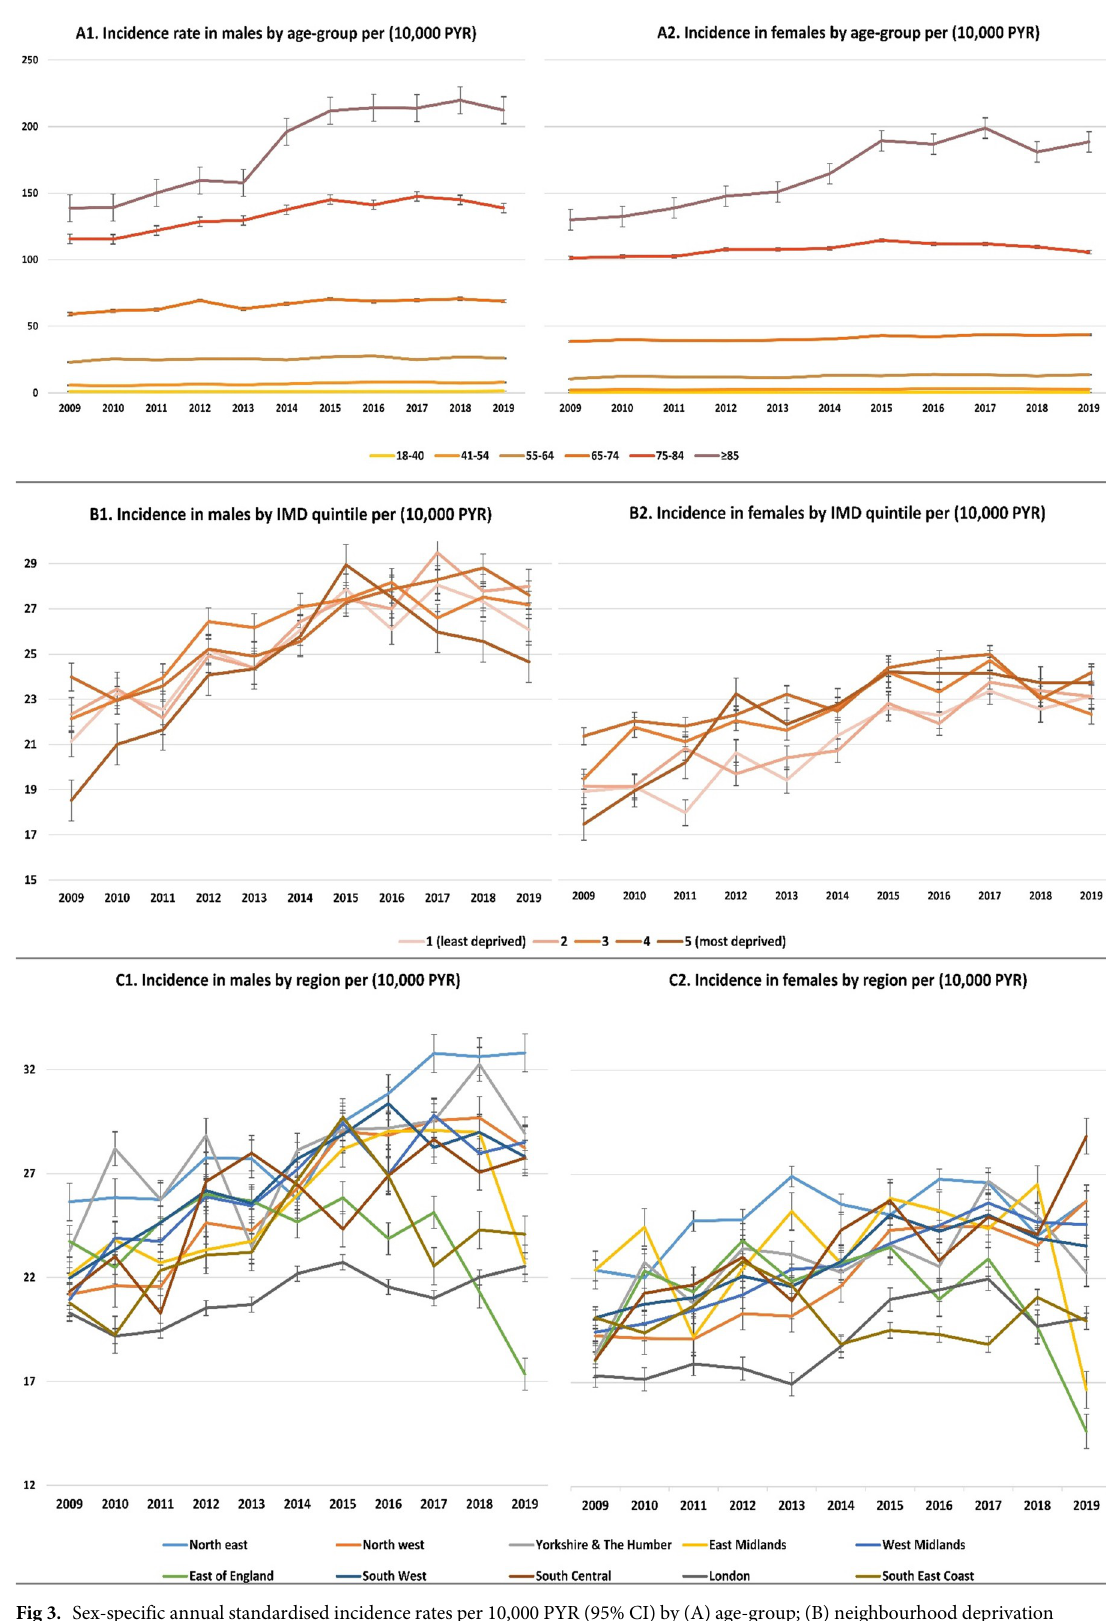
Fig 3. Sex-specific annual standardised incidence rates per 10,000 PYR (95% CI) by (A) age-group; (B) neighbourhood deprivation quintile; and (C) region. CI, confidence interval; IMD, index of multiple deprivation; PYR, person year at risk. https://doi.org/10.1371/journal.pmed.1004003.g003 PLOS Medicine| https://doi.org/10.1371/journal.pmed.1004003 June 7,